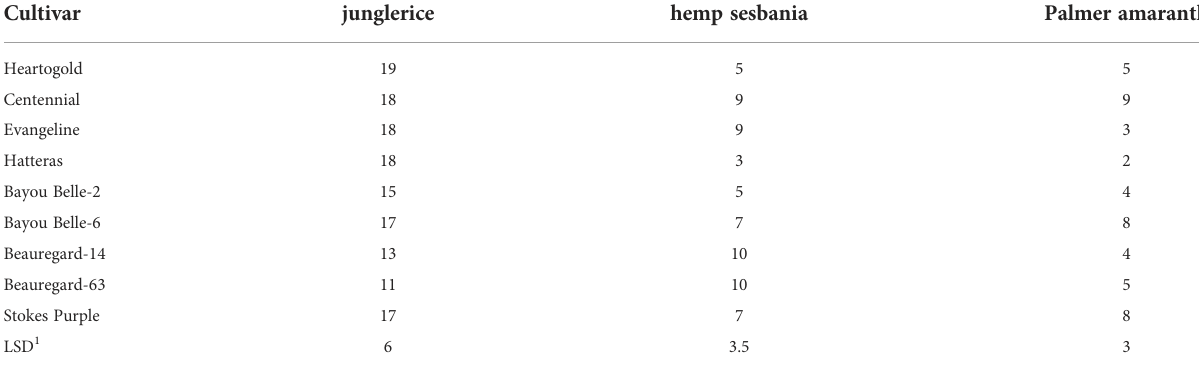
TABLE 2 Height reduction (%) of hemp sebania ( Sesbanea herbacea ), junglerice ( Echinochloa colona ), and Palmer amaranth ( Amaranthus palmeri ) seedlings when watered with root leachates of nine sweetpotato cultivars averaged over four weeks. Cultivar junglerice